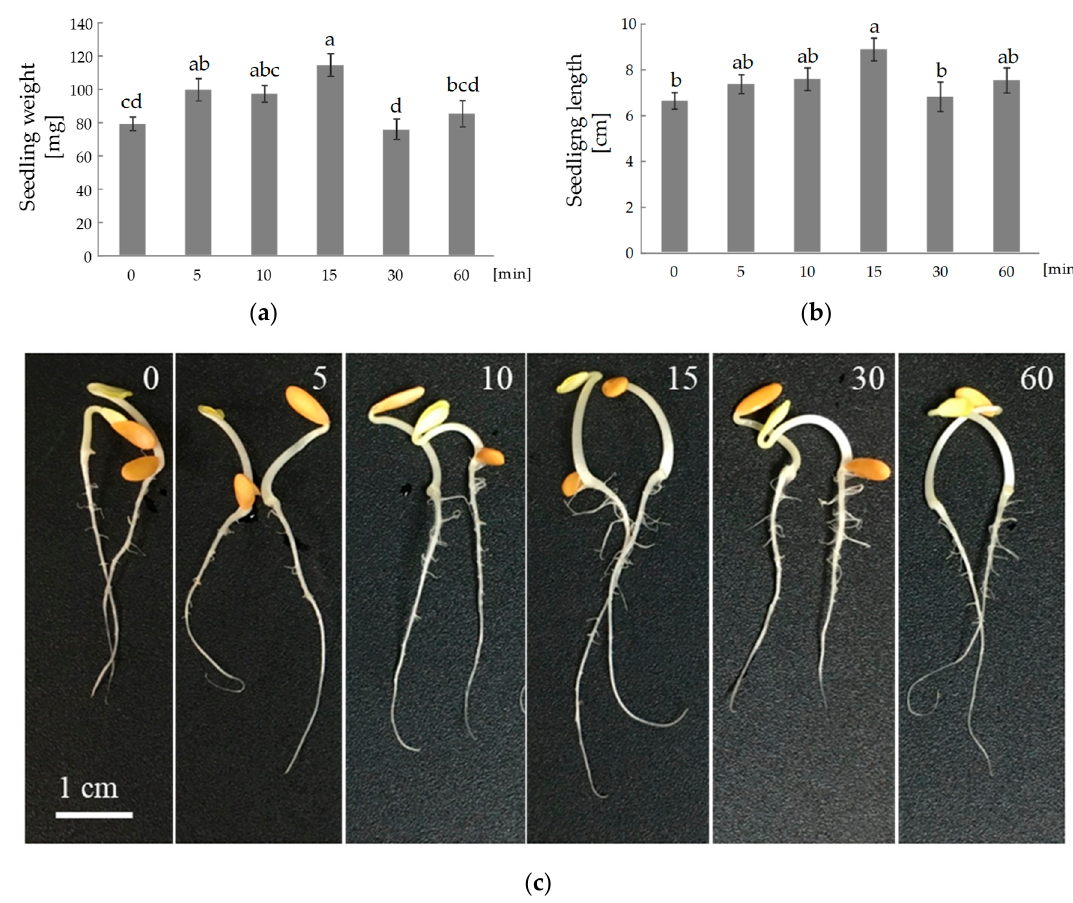
Figure 3. Effect of red light exposure (100 µmol m − 2 s − 1 ) (0–60 min) of melon seeds on the fresh weight ( a ), length ( b ) and overall appearance ( c ) of 3-day-old seedlings. Data represent the mean ± SE from 45 measurements. Different letters indicate significant differences according to Tukey ′ s test ( p ≤ 0.05).